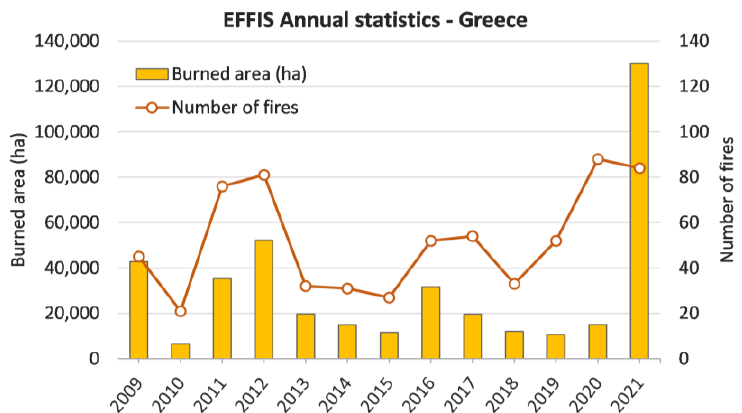
Figure 2. Fire statistics for the years 2009–2021 for Greece derived by the European Forest Fire Information System (EFFIS) reports (https://effis.jrc.ec.europa.eu/apps/effis.statistics/effisestimates, accessed on 1 October 2021).